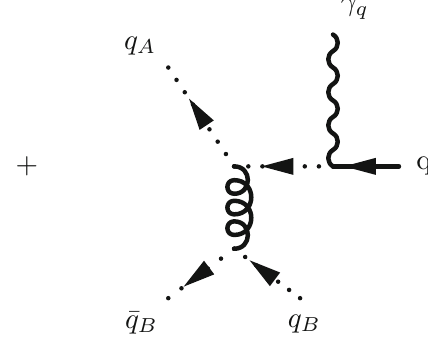
contributing to A ( 1 ∗ , ¯ q ∗+ , q −